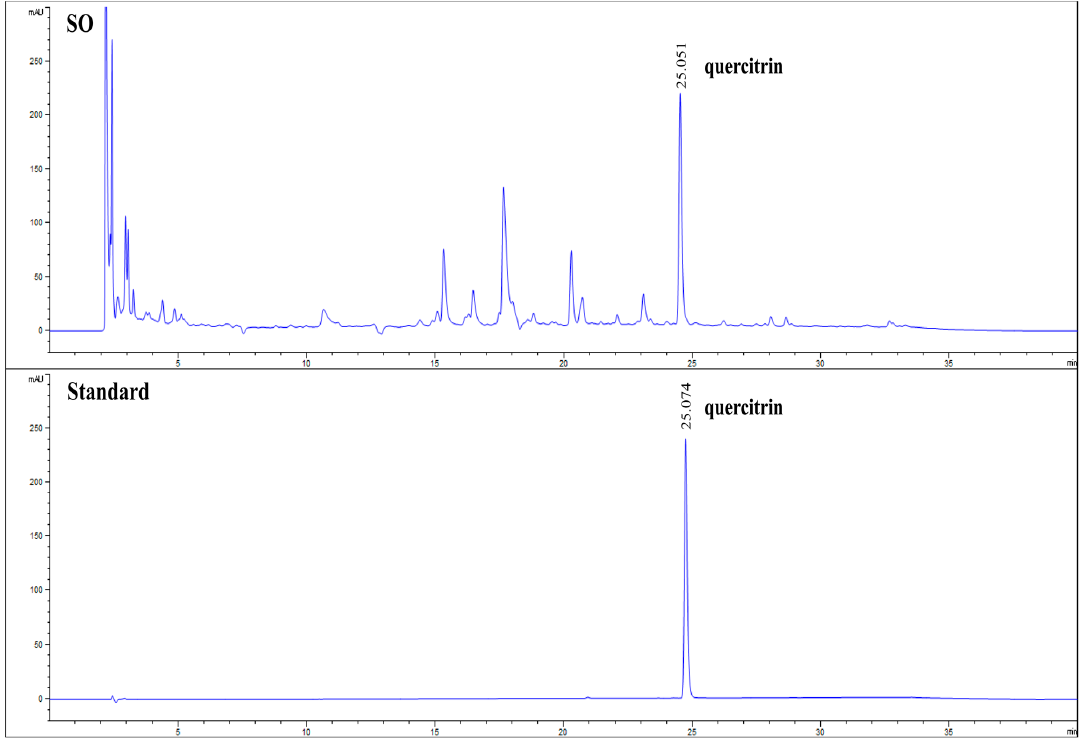
Figure 1. HPLC chromatograms of SO and quercitrin. The identity of quercitrin in SO was determined by comparing the retention times with standards.